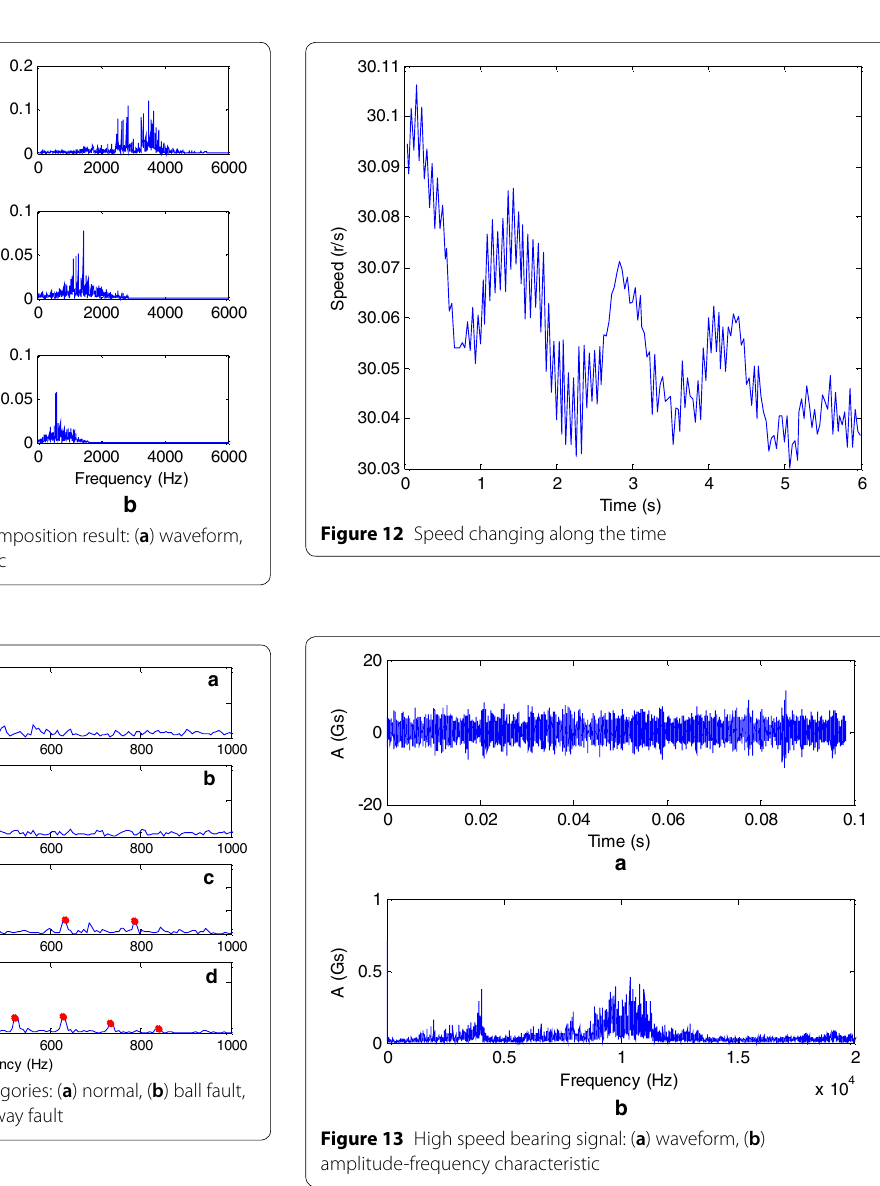
FCM-MMEMD method was implemented for 50 days data. Figure 14 is the FCM cluster result and the data is clustered into 3 classes, namely there are 3 bear- ing states. Take a sample from each class for further analysis. Figure 15 is the waveform and IMF1 Hilbert envelope of the three samples. It is clear that sample 1 (day11) is normal for there is neither shock in waveform nor fault characteristic frequency in Hilbert envelope. Sam- ple 2 (day34) are the signals with fault, because fault characteristic frequency of 280.1 Hz (corresponding to inner raceway fault, 284.3 Hz) can be found in Hilbert